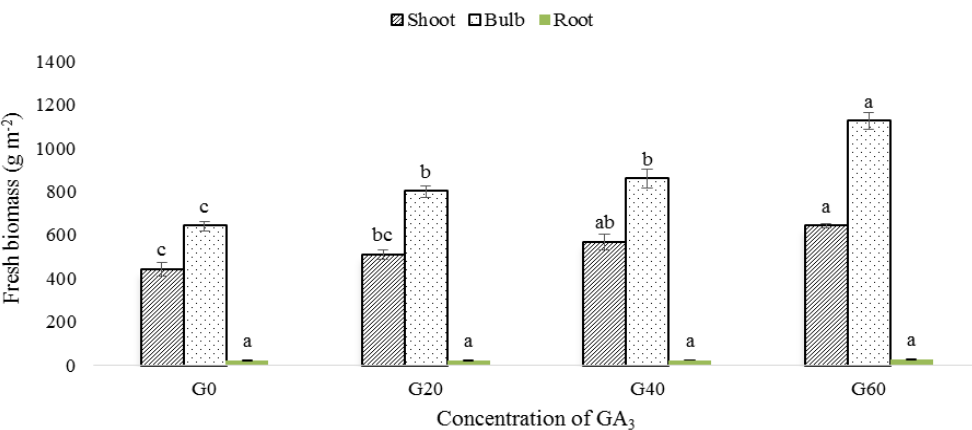
Fig. 3. Effect of GA on fresh shoots, bulbs and root biomass at harvest time in onion. Vertical bar represents means ± standard 3 error mean. Means with the same letter did not significantly differ from each other at p < 0.05. Abbreviations are as follows, G G ; 20, G ; 40 and G ; 60 ppm GA 20 40 60 3